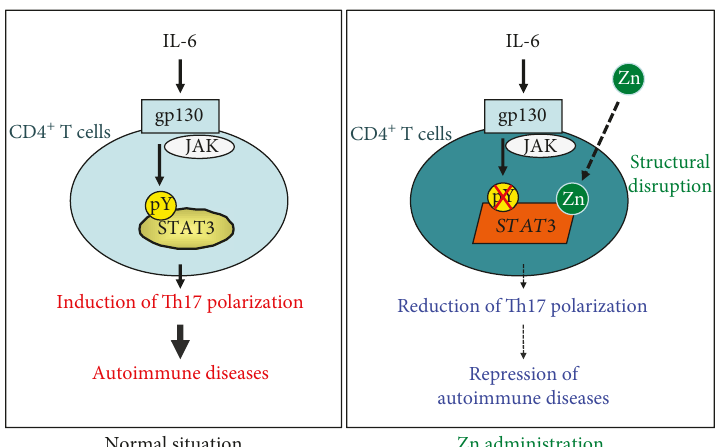
Figure 4: Zinc suppresses autoimmune diseases by inhibiting STAT3 activation. Zinc directly binds STAT3, altering its structure. The structurally altered STAT3 molecule cannot e ff ectively transduce the IL-6 signaling pathway; this pathway is critical for autoimmune diseases involving Th17 cells. Zn: zinc; IL-6: interleukin-6; STAT3: signal transducer and activator of transcription 3; JAK: Janus